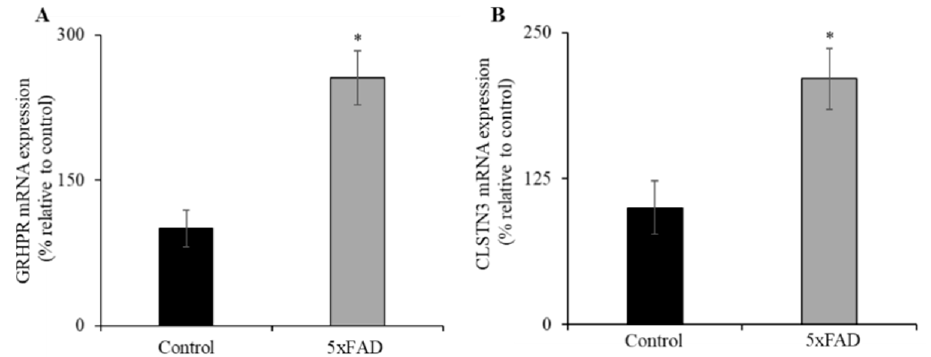
Figure 5. Increased levels of expression of vitamin C transporters interacting protein partners (glyoxylate reductase/hydroxypyruvate reductase (GRHPR) and Calsyntenin 3 (CLSTN3)) in 5xFAD mice jejunum mucosa. ( A , B ) RT-qPCR was done using cDNA prepared from 5xFAD and WT littermate mice jejunum mucosa, and GRHPR and CLSTN3 primers, and normalized relative to simultaneously amplified β -actin. Values are means ± SE of at least seven mice ( n = 7–8) samples. * p < 0.01.